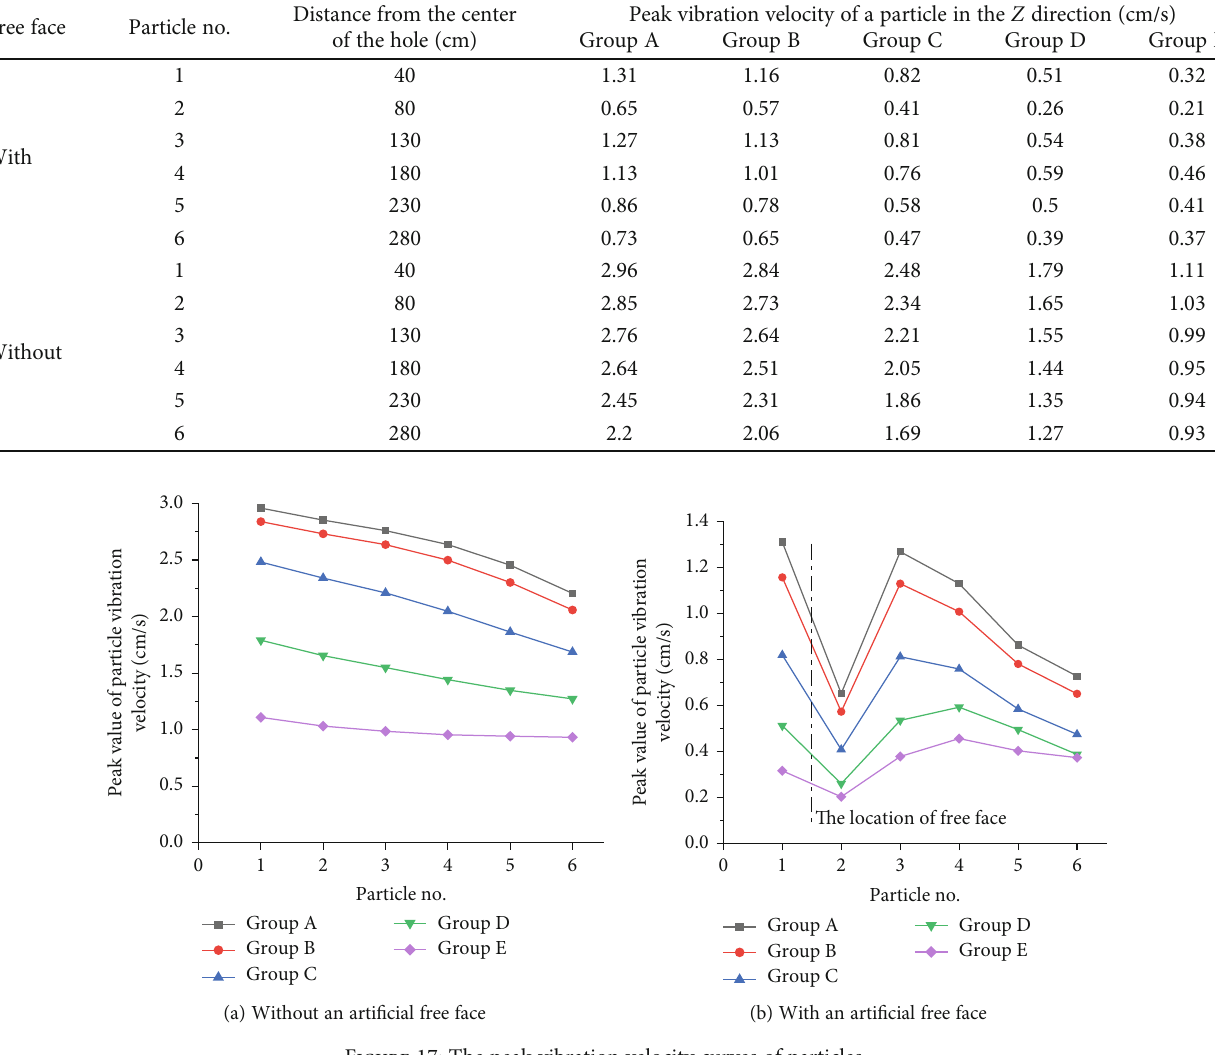
Table 10: Peak values of the particle vibration velocity in the Z direction.